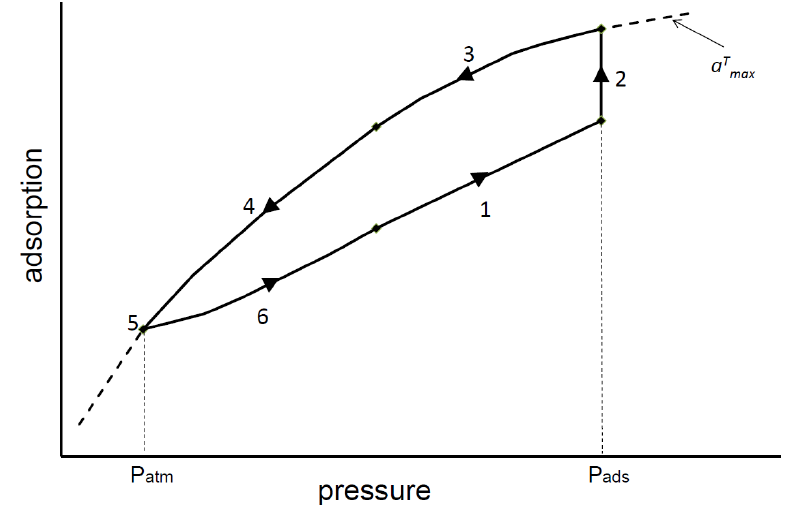
Figure 3. The cycle of changes in pressure and adsorbency of the bed inside a single PSA tank. a T max —the maximum nitrogen adsorption at the process temperature; 1—air